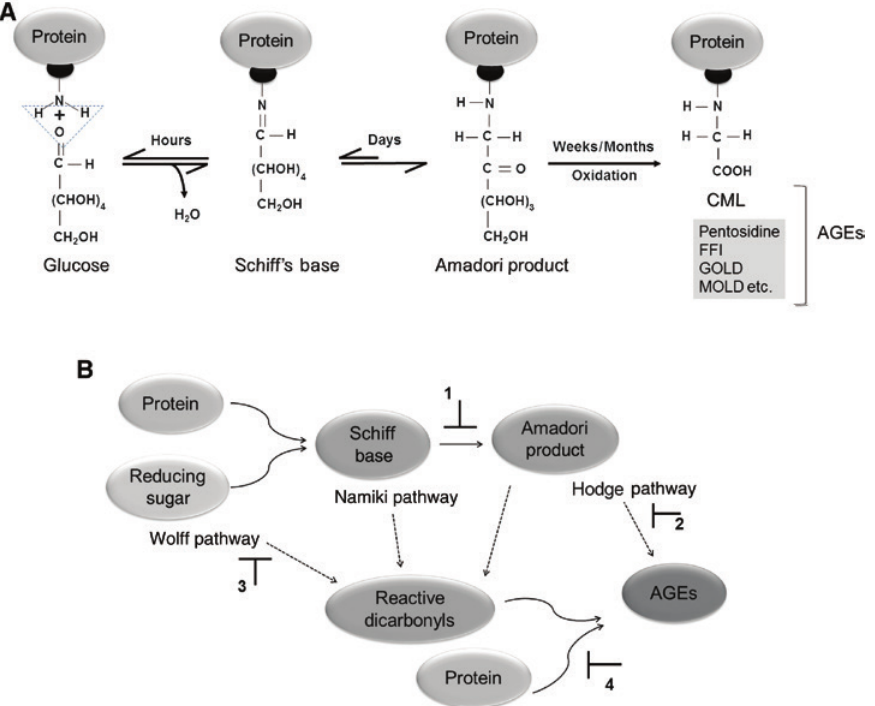
Figure 1: Mechanism and pathways of formation of advanced glycation end products. (A) Classical reactions in the formation of advanced glycation endproducts (AGEs). The initial nonenzymatic interaction between the highly reactive carbonyl group of glucose with a free amino group on proteins creates a reversible Schiff’s base, which spontaneously undergoes rearrangement itself into a partially reversible Amadori product. Amadori products rearrange to form heterogeneous AGEs including CML, pentosidine, FFI, MOLD and GOLD. (B) A complex network of NEG reactions. Highly reactive carbonyl intermediates (glyoxal, methylglyoxal and 3-deoxyglucosone) can be formed from the auto-oxidation of monosaccharides (e.g. glucose: Wolff pathway) or from Schiff’s base (Namiki pathway) or from Amadori products (Hodge pathway). The highly reactive intermediates that are formed by these three pathways can react with free amino groups to form diverse AGEs. The possible sites that could be targeted to inhibit NEG and to prevent AGEs medi- ated complications are indicated in numbers